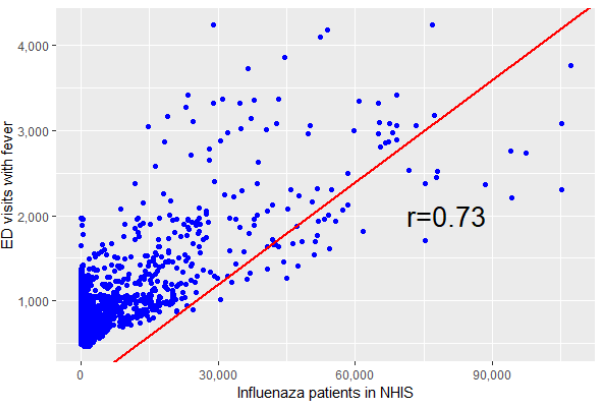
Figure 2. Correlation coefficient between the seven-day moving average of ED visits with fever and daily patients of influenza in the